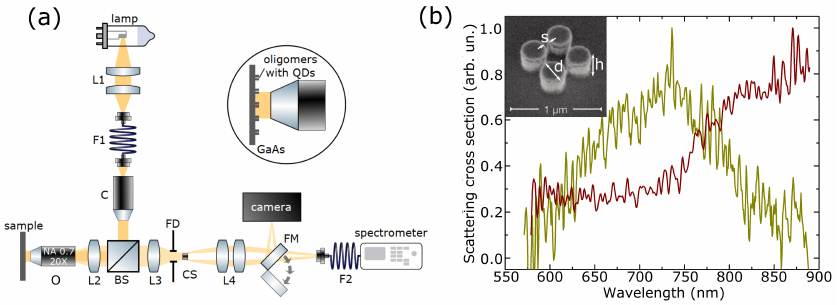
Figure 2. Optical characterization of the quadrumer. ( a ) Experimental setup for dark-field spectroscopy measurements of quadrumers with embedded QDs. L1:4 are lenses, O is the objective lens, F1:2 are optical fibers, C is collimator, BS is the beam splitter, FM is the flipper mirror, FD is the field aperture. ( b ) Experimental scattering cross-section spectra of isolated oligomers of nanopillars with diameters of 220 nm (yellow) and 260 nm (red). Inset shows scanning electron microscope image of the sample of Mie-resonant quadrumers coupled with QDs; spacings between nanopillars are s = 100 ± 5 nm; diameters are d = 250 ± 5 nm; heights are h = 400 ± 5